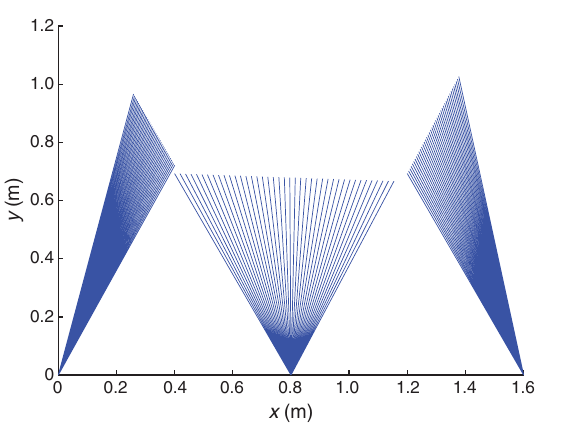
Fig. 6. Geodesic gait simulation of the whole walking cycle.